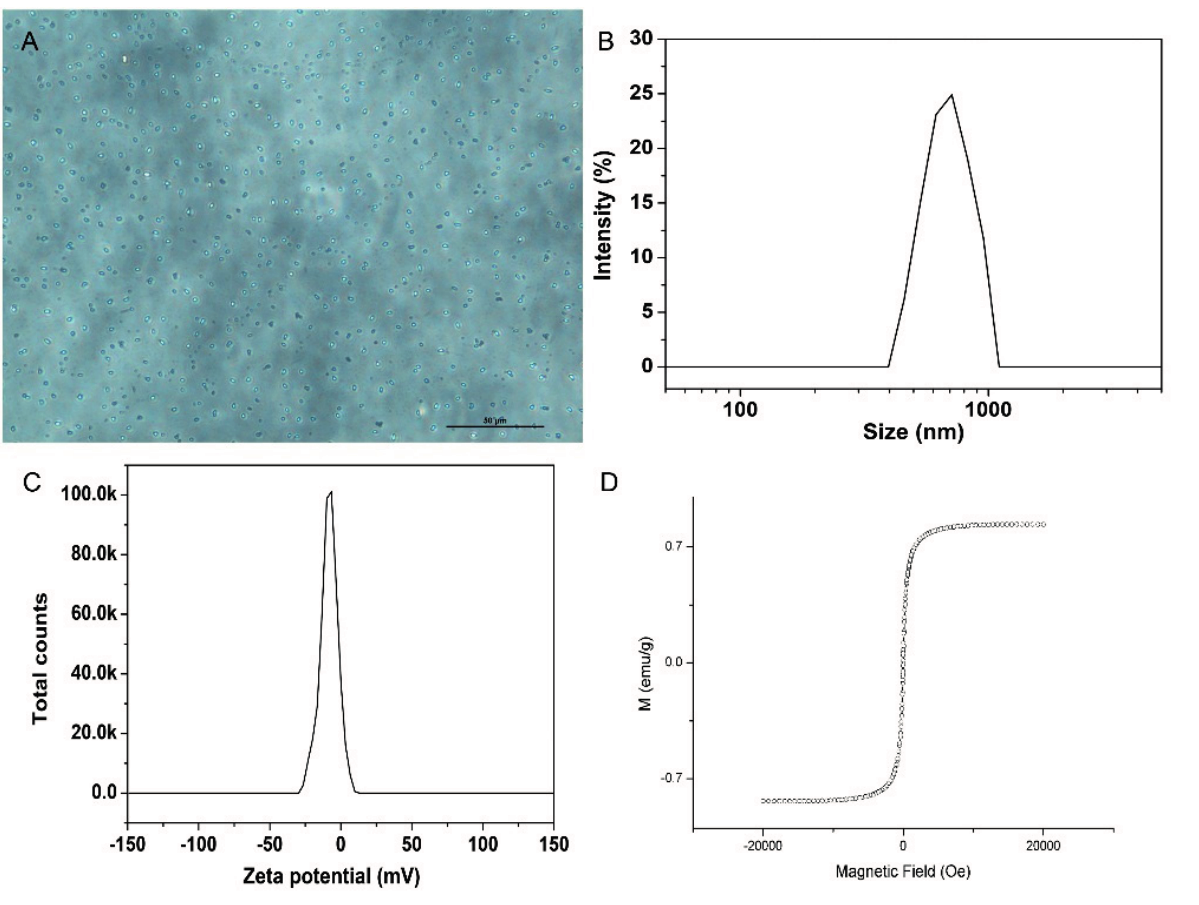
Figure 1. Characterization of polypeptide-SPIONs. ( A ) Light microscope of polypeptide-SPIONs (×400); ( B ) Size distribution of polypeptide-SPIONs; ( C ) Zeta potential of polypeptide-SPIONs; ( D ) VSM curve of